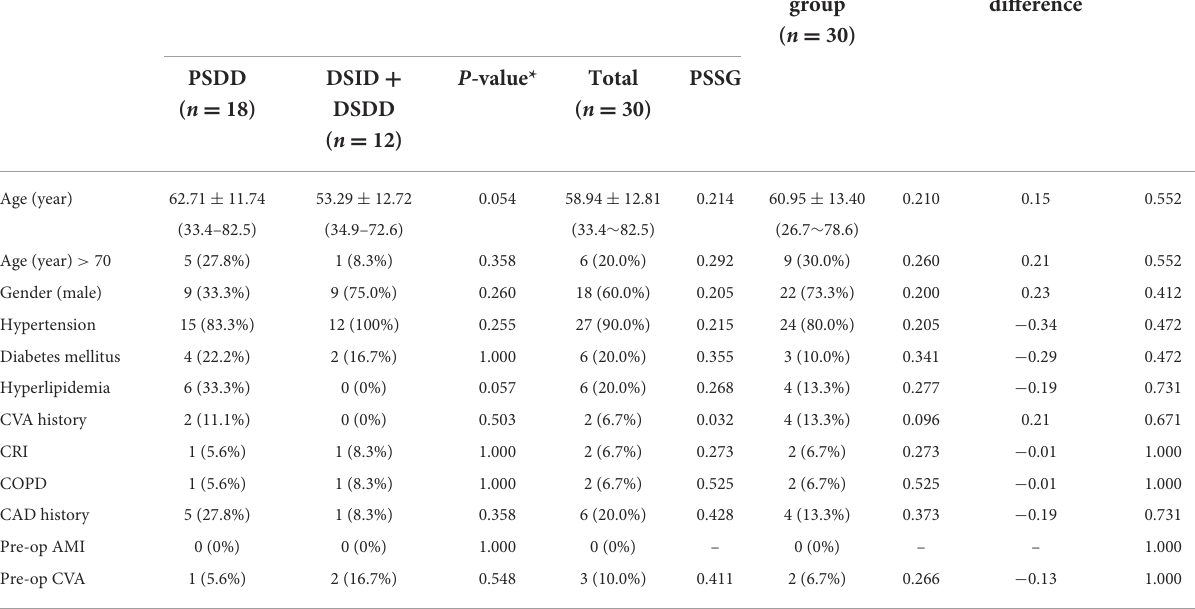
TABLE 1 Characteristics of all patients with type A aortic dissection: study group (non-prompt surgery after symptom onset; control group: prompt surgery after symptom onset).